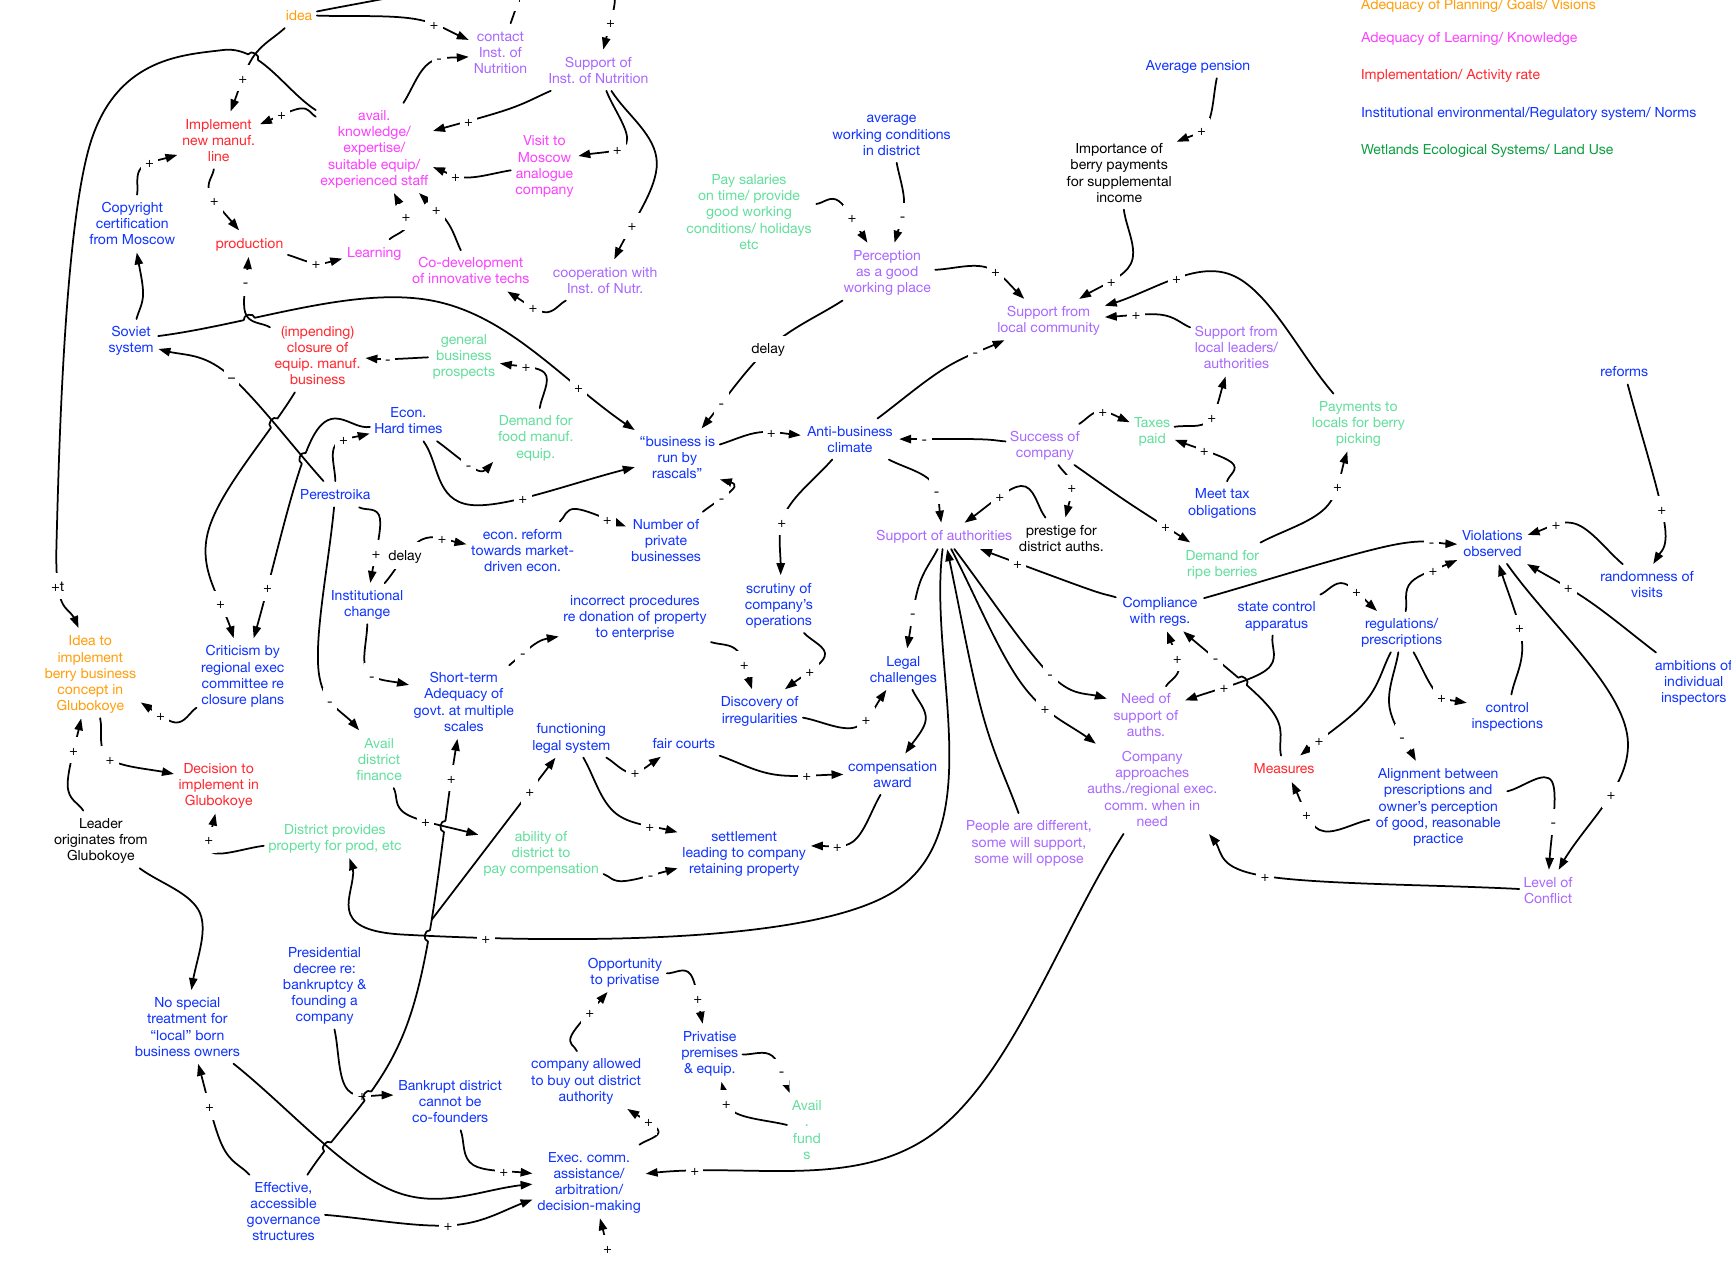
Figure A2:13. Case Berries, Theme: